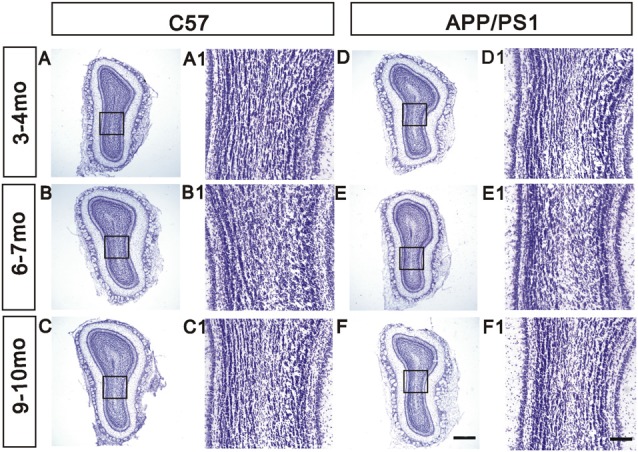
Unchanged laminar organization of the OB in APP/PS1 mice. (A–F) No significant change in the laminar organization of the OB was observed between APP/PS1 and age-matched C57 mice at different ages. (A1–F1) High-magnification images showing the structure of the GCL. Scale bars = 500 μm in (F; applies to A–F) and 100 μm in (F1; applies to A1–F1).